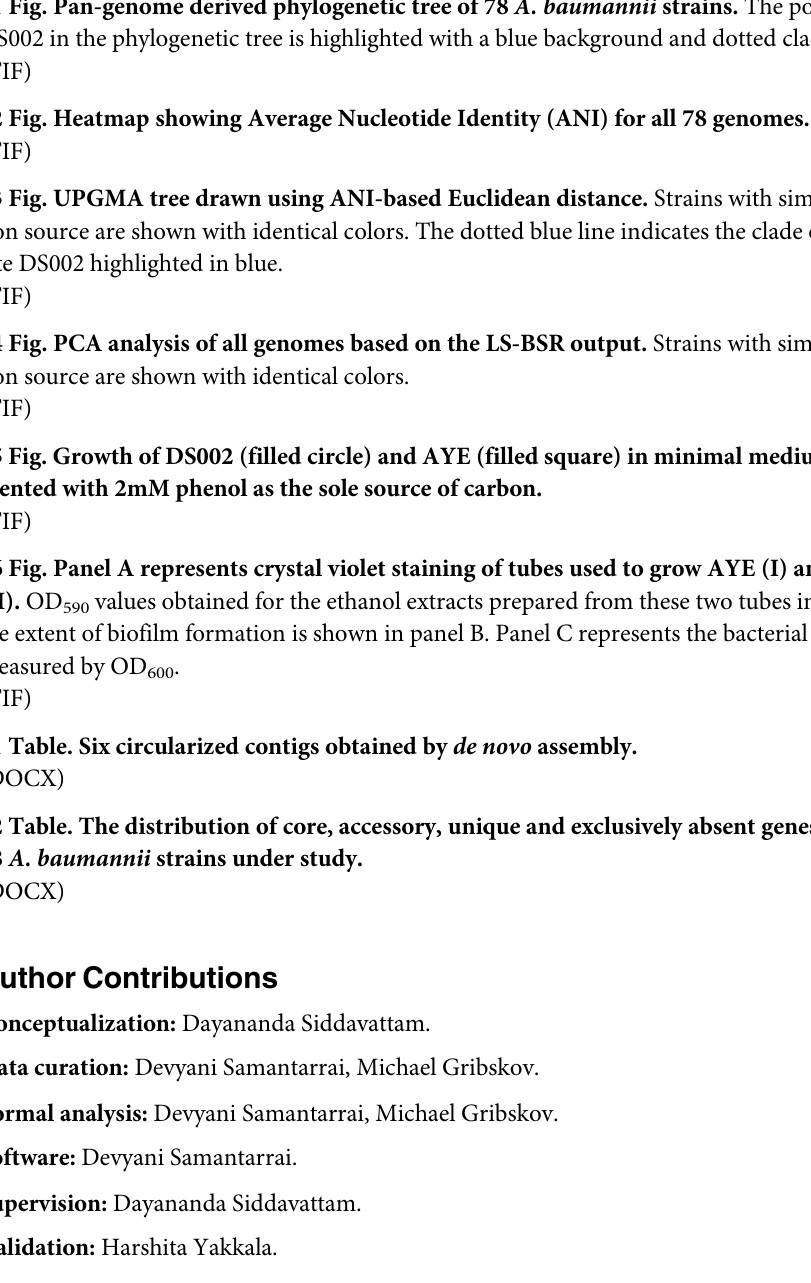
S1 Fig. Pan-genome derived phylogenetic tree of 78 A. baumannii strains. The position of DS002 in the phylogenetic tree is highlighted with a blue background and dotted clade line. S2 Fig. Heatmap showing Average Nucleotide Identity (ANI) for all 78 genomes. S3 Fig. UPGMA tree drawn using ANI-based Euclidean distance. Strains with similar isola- tion source are shown with identical colors. The dotted blue line indicates the clade of soil iso- late DS002 highlighted in blue. S4 Fig. PCA analysis of all genomes based on the LS-BSR output. Strains with similar isola- tion source are shown with identical colors. S5 Fig. Growth of DS002 (filled circle) and AYE (filled square) in minimal medium supple- mented with 2mM phenol as the sole source of carbon. S6 Fig. Panel A represents crystal violet staining of tubes used to grow AYE (I) and DS002 (II). OD values obtained for the ethanol extracts prepared from these two tubes indicating 590 the extent of biofilm formation is shown in panel B. Panel C represents the bacterial growth as measured by OD . 600 S1 Table. Six circularized contigs obtained by de novo assembly. S2 Table. The distribution of core, accessory, unique and exclusively absent genes in all